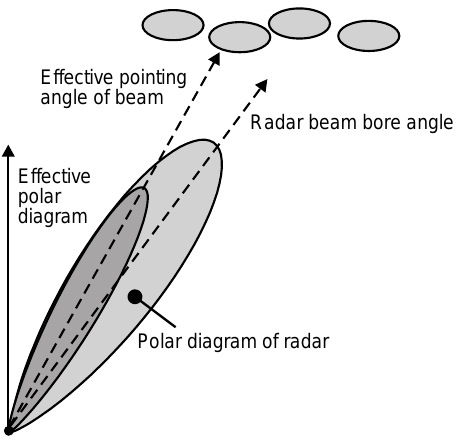
Fig. 3. Schematic diagram showing how anisotropic scatterers alter the e(cid:128)ective beam pattern for a Doppler radar. The bulk of the radio scatter comes back through the ‘‘e(cid:128)ective beam’’, rather than the true beam, due to the asymmetry introduced by the